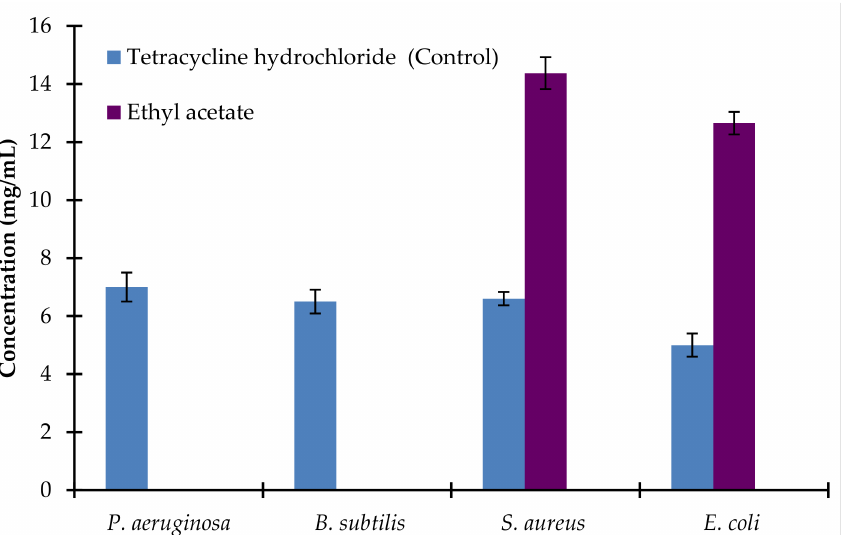
Figure 4. MBC values for ethyl acetate Avicennia marina leaf extract against P. aeruginosa, B. subtilis, S. aureus, and E. coli . Tetracycline hydrochloride was a positive control. Aqueous, ethanol, petroleum ether, and chloroform extracts did not affect any tested bacterial strains. Ethyl acetate extract did not affect P. aeruginosa and B. subtilis . Values are the mean of five replicates ( n = 5). Vertical bars show standard